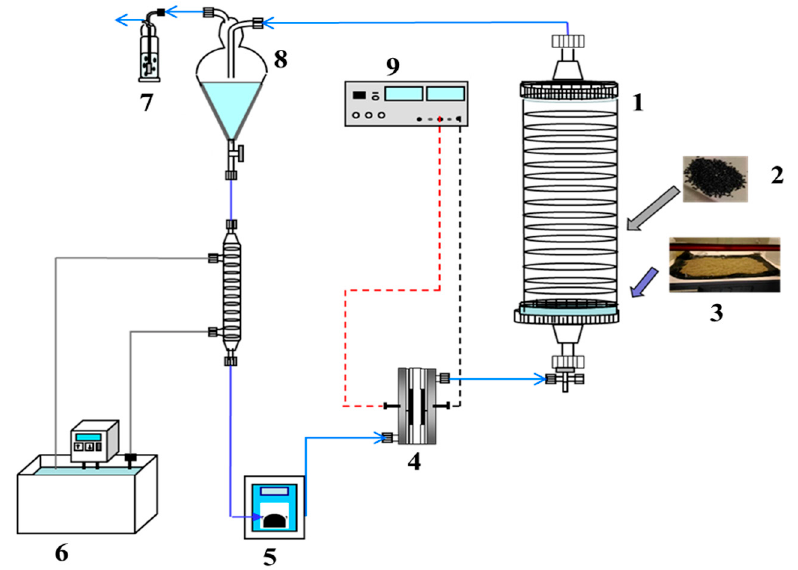
Figure 10. Schematic of concurrent SW / zero valent iron (ZVI) dehalogenation and electrochemical oxidation processes for remediation of soil contaminated by herbicide clopyralid. ( 1 ) SW reactor; ( 2 ) ZVI; ( 3 ) Contaminated soil; ( 4 ) Electrochemical reactor; ( 5 ) Peristatic pump; ( 6 ) Thermostatic cooling system; ( 7 ) Secondary tank; ( 8 ) Gas exchange; ( 9 ) DC power generator. Adapted from [130].